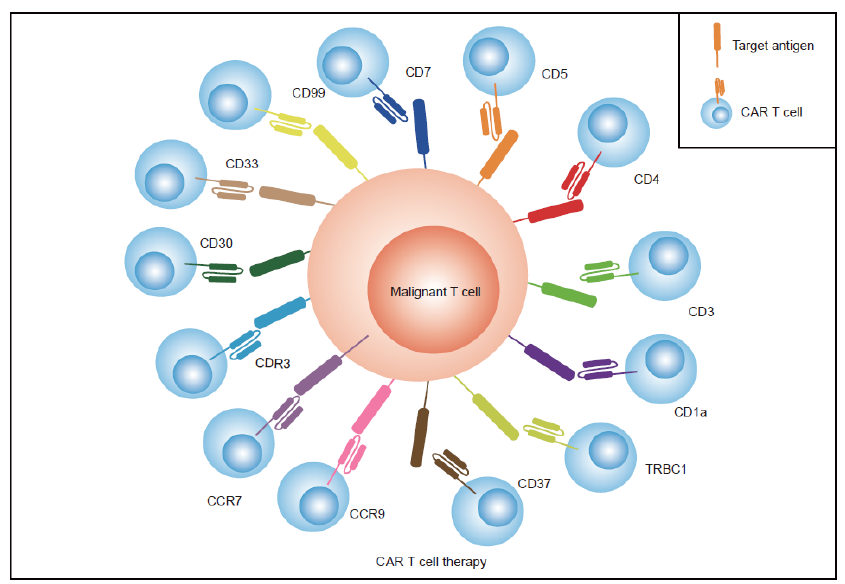
Figure 1. Three major challenges of CAR T therapy. ( A ) Fratricide: CAR T cells, as they have target antigens, kill each other. ( B ) T-cell aplasia: CAR T cells recognize the antigen, which has expressions on both malignant and normal T cells, and then kill the normal T cells. ( C ). Product contamination: tumor T cells are mixed in with sorted T cells and are transduced with CAR.